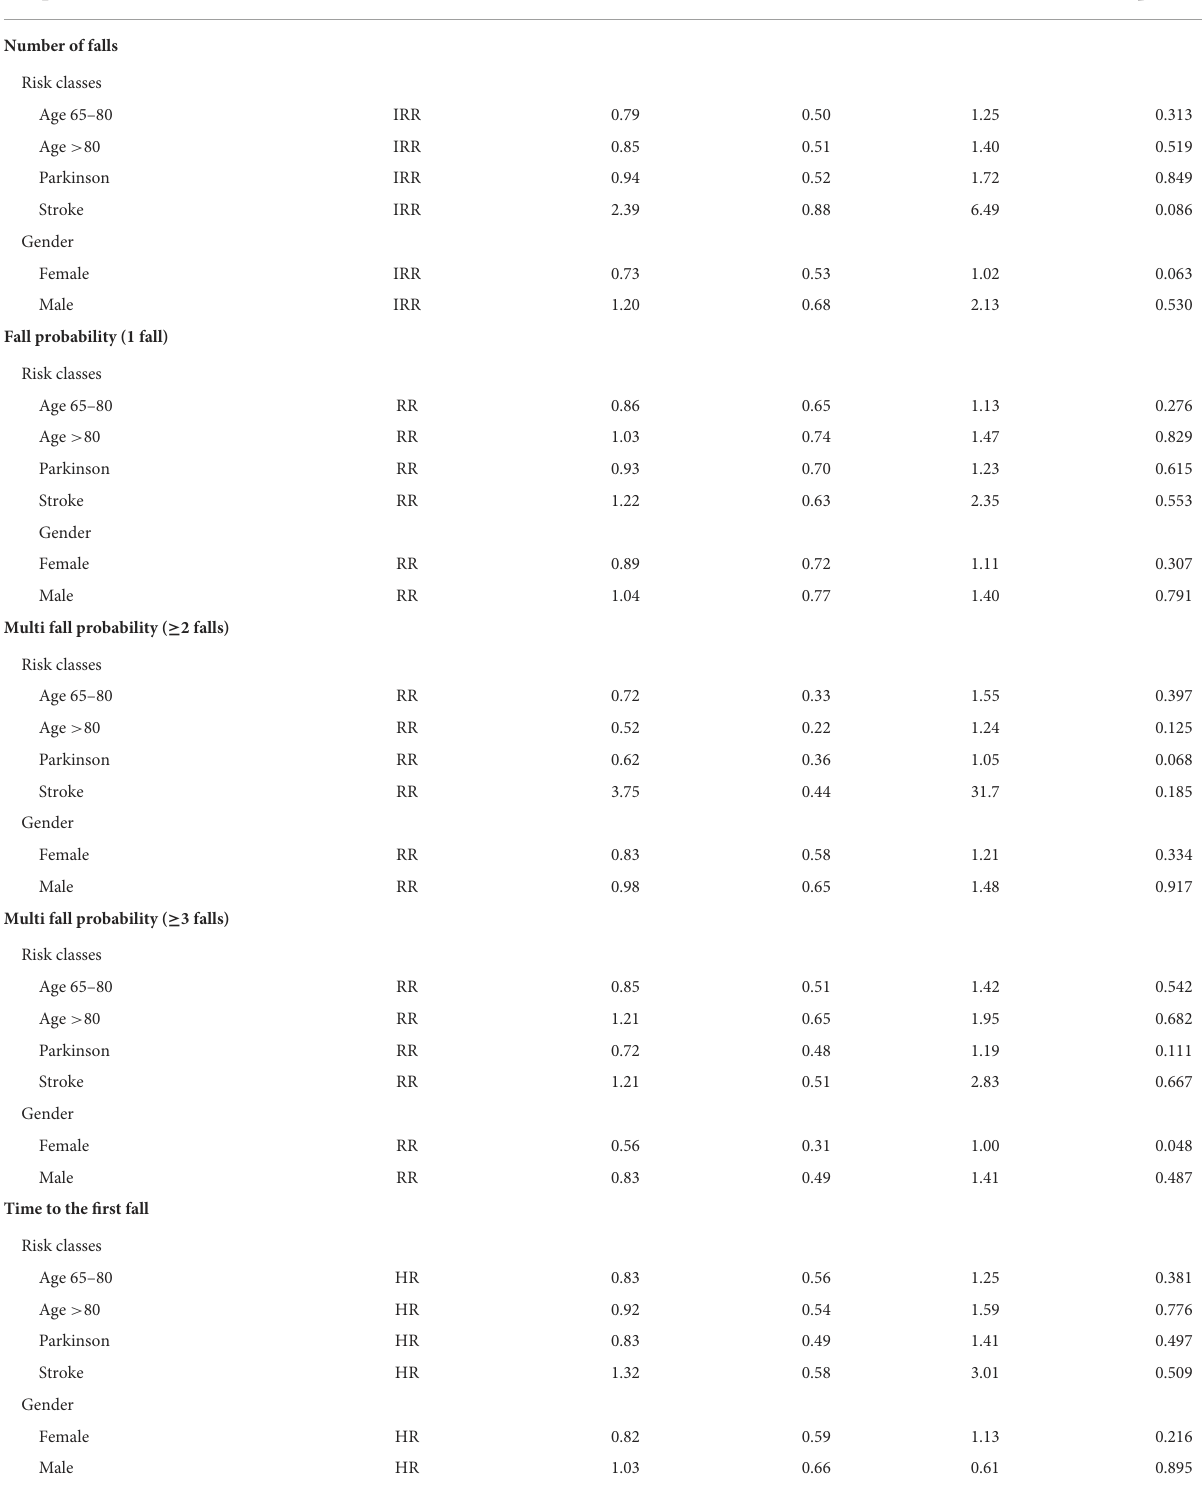
TABLE 6 Analysis of observed differences between subgroups in the IG and